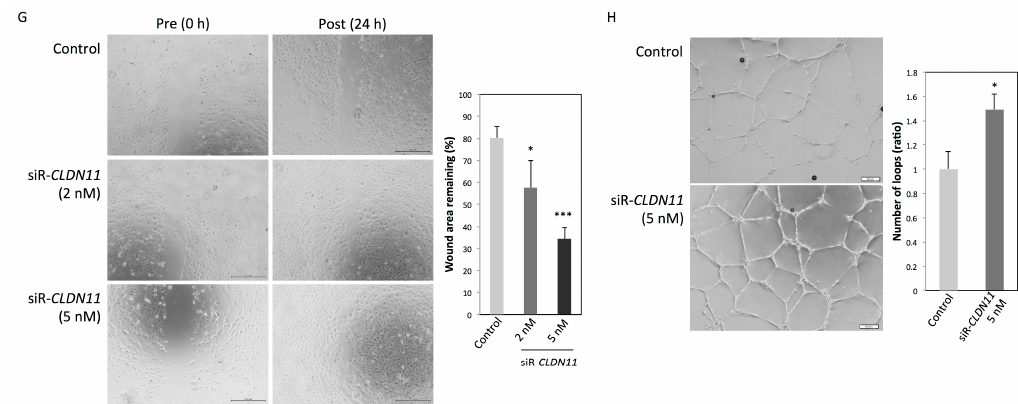
Figure 4. MiR-92a-3p induces a pro-angiogenic state in endothelial cells through the downregulation of CLDN11 . ( A ) Relative expression levels of CLDN11 mRNA in four colon cancer cell lines: GAPDH was used as an endogenous normalizer for CLDN11 expression. ** p < 0.01; *** p < 0.001. ( B ) Relative expression levels of CLDN11 mRNA and ( C ) CLDN11 protein in HUVECs at 48 h after incubation with EVs or transfection with miR-92a-3p or nonspecific control miRNA. * p < 0.05, ** p < 0.01, and *** p < 0.001. ( D ) Predicted binding site for miR-92a-3p in the 3’UTR region of human CLDN11 mRNA (region A shown as a dotted box). Mutant-type pMIR contained a mutated seed sequence (from CAA to UCG). Luciferase activities after incubation with EVs or co-transfection of HUVECs with miR-92a-3p or nonspecific control miRNA and wild-type or mutant pMIR-A vector. ** p < 0.01. ( E ) Cell proliferation ratio and ( F ) relative expression levels of CLDN11 protein at 48 h after transfection of HUVECs with siR- CLDN11 or nonspecific control miRNA. *** p < 0.001. ( G ) Migration assay and ( H ) tube formation assay in HUVECs transfected with siR- CLDN11 or nonspecific control miRNA. Scale bars: 500 µ m in Figure 4G and 200 µ m in Figure 4H. * p < 0.05; *** p < 0.001. miRNA, microRNA; HUVEC, human umbilical vein endothelial